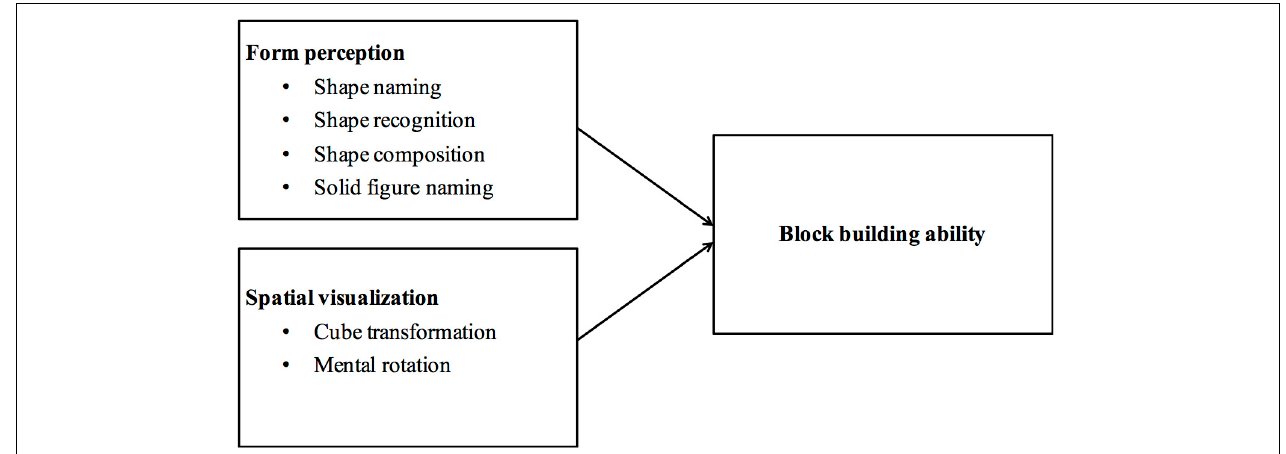
FIGURE 1 | Schematic model of spatial skills underlying block-buildings